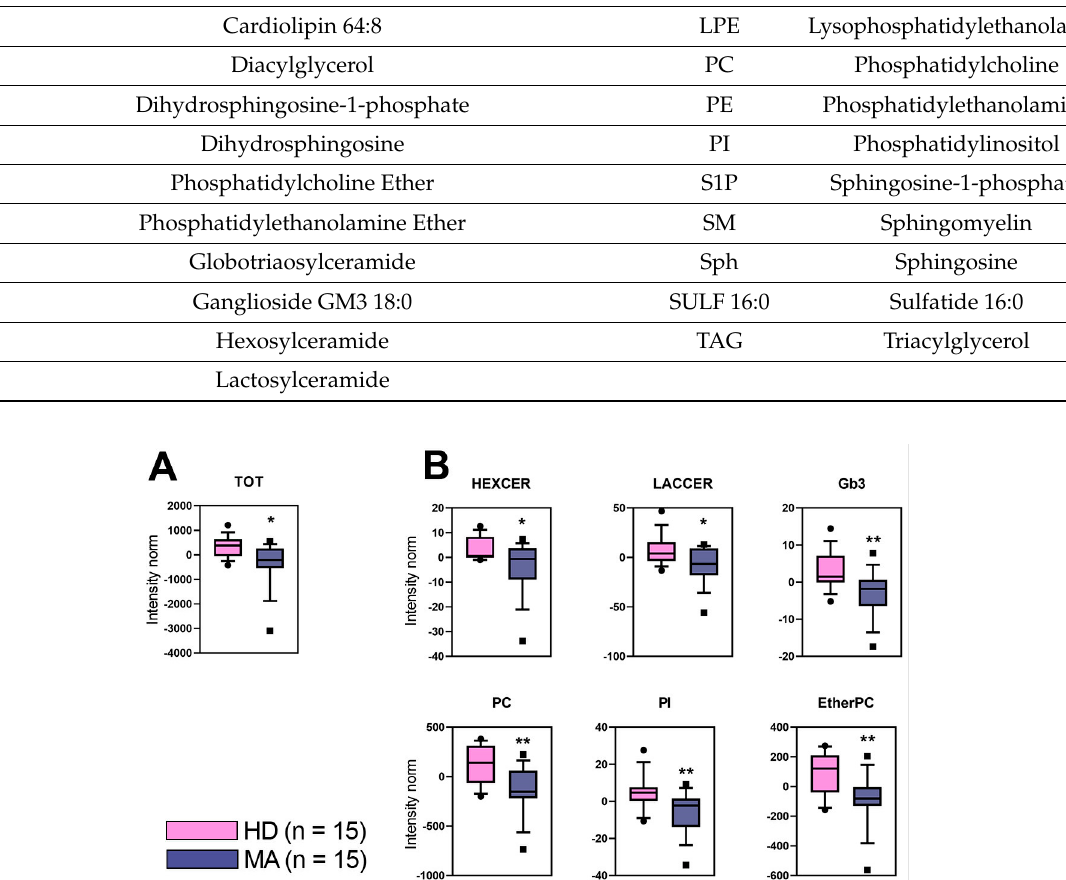
Figure 2. ( A ) Total lipid content in plasma of MA patients (MA, n = 15) and of healthy donors (HD, n = 15). ( B ) Lipid classes significantly decreased in plasma of MA patients. Other lipid classes were not visualized since their alteration does not reach any statistical significance. In this analysis, all lipids identified in the same class were summed and included in the boxplots. Data were reported as log-transformed and auto-scaled mass intensities (Intensity norm). Statistical significance was evaluated by unpaired t -test. p values are schematized as follows: * < 0.05; ** < 0.01. The discriminant analysis (PLS-DA) even better elucidated the lipidomic profiles dif- ferences among the two groups and showed a separation of 23.1% on principal component (PC1). The PC1 represents the new dimension in which the initial variables are compressed and represents the maximum of the separation that can be reached within these clusters and variables (Figure 3A). The Variance Importance in Projection scores (VIP) derived